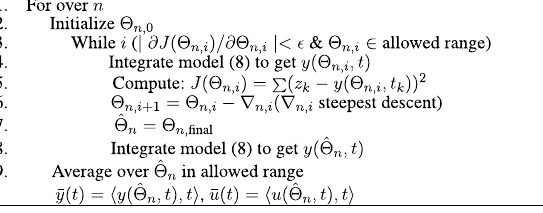
Algorithm 1 . The algorithm consists of two nested loops: the outer one loops over a random set of initial conditions { Θ n ,0 }, and the inner loop is based on the Levenberg-Marquardt method where the value Θ n is updated on the i th cycle by Θ n , i +1 = Θ n , i − ∇ ∇ n , i where n , i uses the steepest descent method (Marquadt, 1963; Levenberg, 1944). We use the MATLAB function ‘ lsqcurve fi t ’ to implement this inner loop.